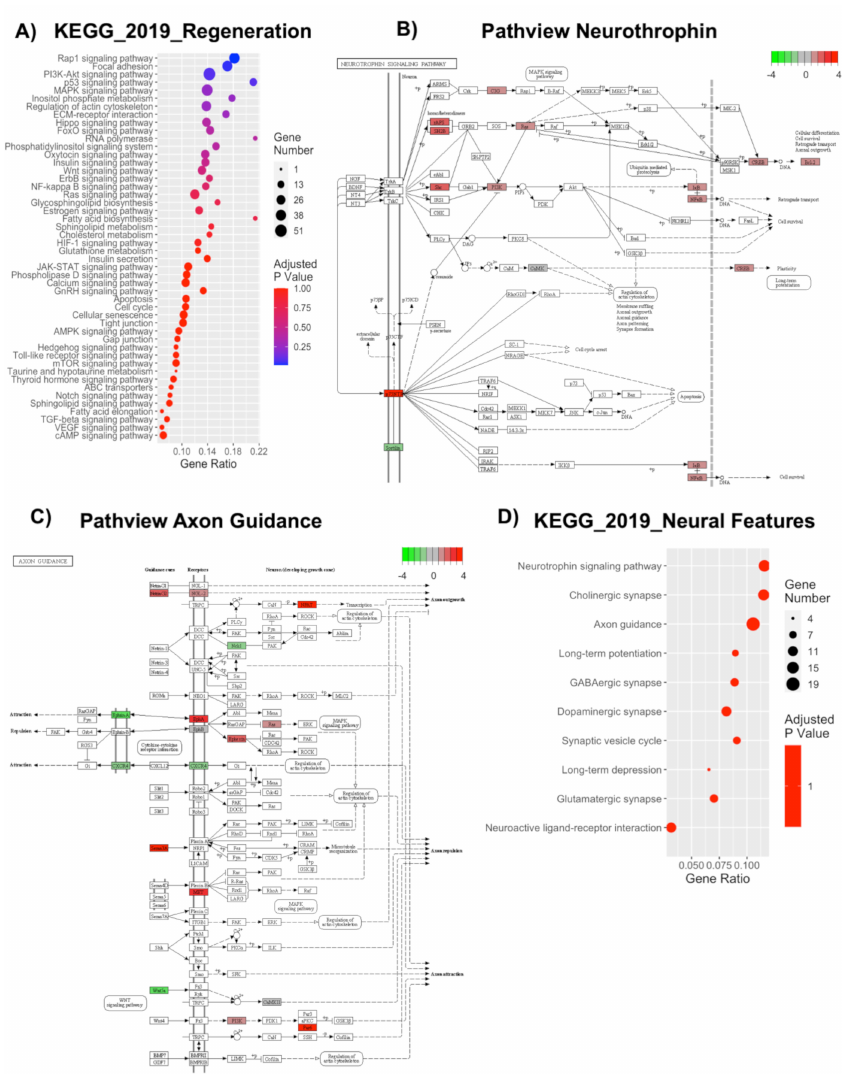
Figure 7. Deregulated pathways and genes correlated with regeneration and neural features. ( A ) KEGG analysis highlighted 48 deregulated pathways for regenerative processes. ( B , C ) Pathview of neurotrophins signaling pathway and axon guidance, respectively. In red, upregulated genes are shown, whereas in green, downregulated ones are shown. ( D ) KEGG analysis of neural features highlighted 10 deregulated pathways. The y-axis represents the name of the pathway, the x-axis represents the Rich factor, dot size represents the number of di ff erent genes, and the color indicates the adjusted p